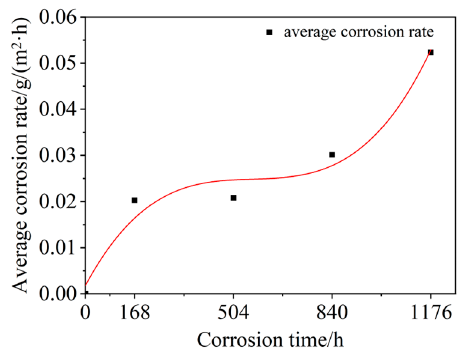
Figure 4. Corrosion rate of the SPR joints with different SSC durations.